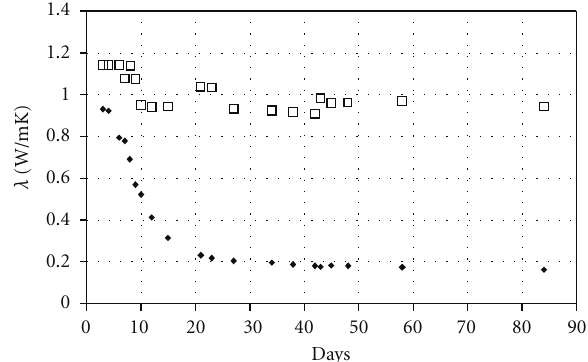
Figure 11: Evolution of λ 1 (W/mK) thermal conductivity with the saturation index ( I sat ) in the earth brick.